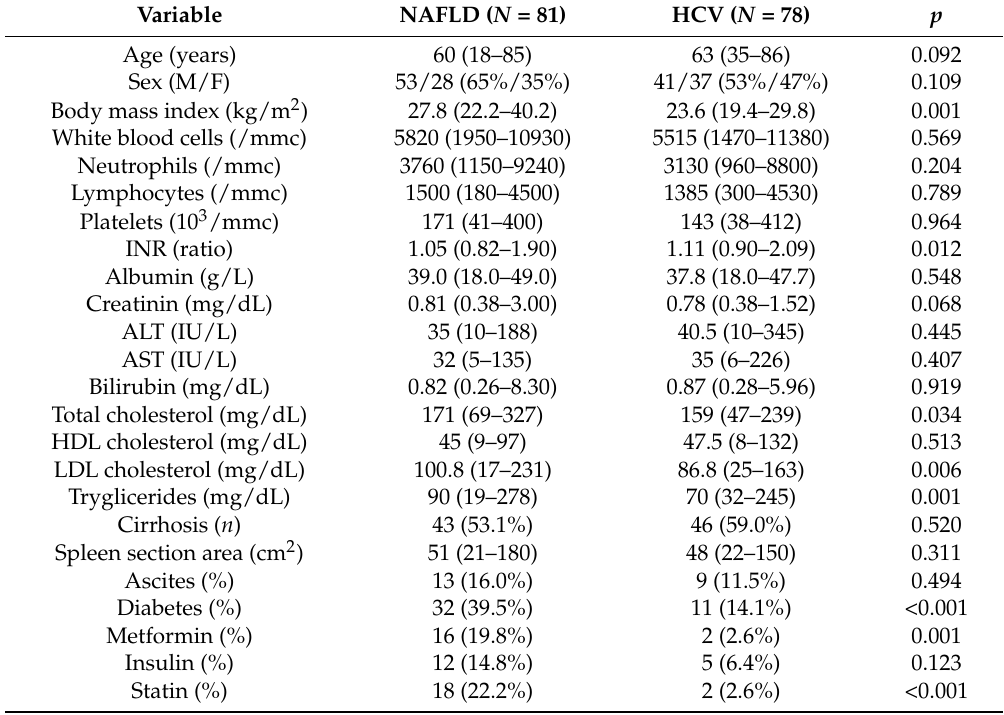
Table 1. Main demographic, clinical, and laboratory findings of patients with non-alcoholic fatty liver disease (NAFLD) and hepatitis C virus (HCV)-related chronic liver disease. Continuous variables are expressed as median (range). Categorical variables are espressed as number of patients